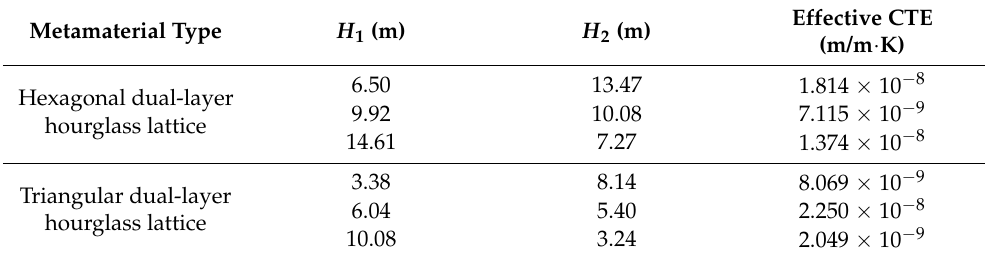
Table 3. Results of effective CTE in thickness direction in several height parameters.